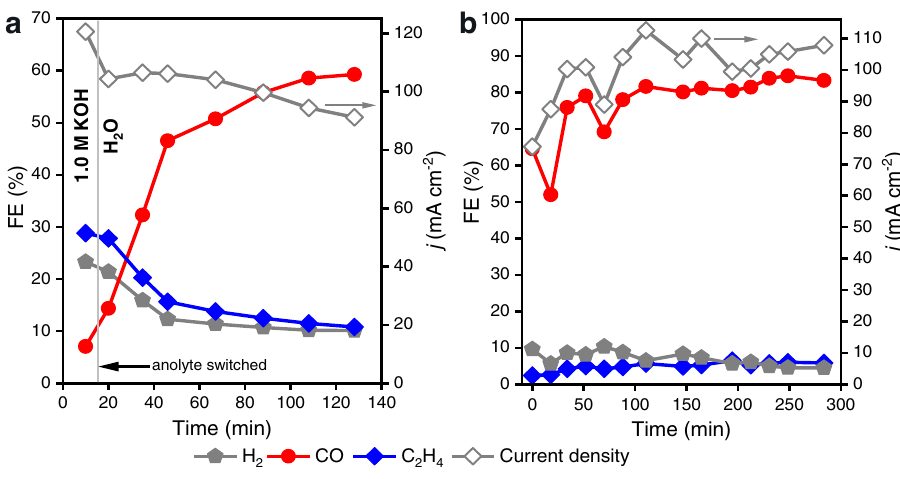
Fig.2|Reversibilityandstabilityofcationeffectsundercontinuousoperation. a FEandcurrentdensityvstimeforadevicetestedcontinuouslywithinitialanolyte 1.0M KOH, which at 10min was exchanged with pure water. b FE and current